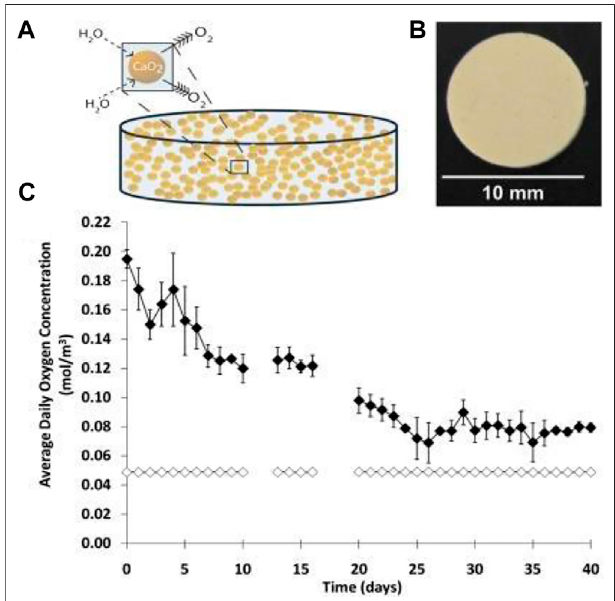
FIGURE 8 | Schematic showing oxygen-generating PDMS-CaO 2 disc (A) . Photograph of PDMS-CaO 2 disk (10mm diameter; 1mm height) (B) . Oxygen releasing screening of PDMS- CaO 2 disk ( fi lled diamonds) compared to blank PDMS disk (open diamonds) during 40 days (C) (Pedraza et al.,